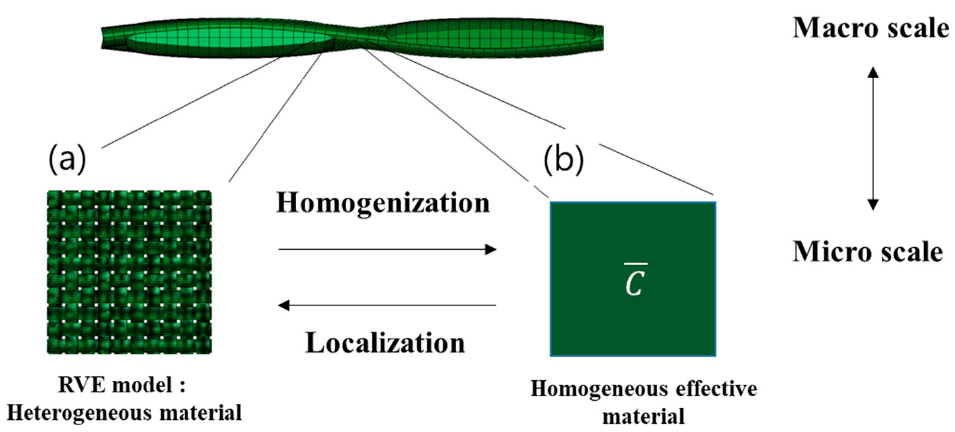
Figure 2. ( a ) Homogenization and ( b ) localization of RVE